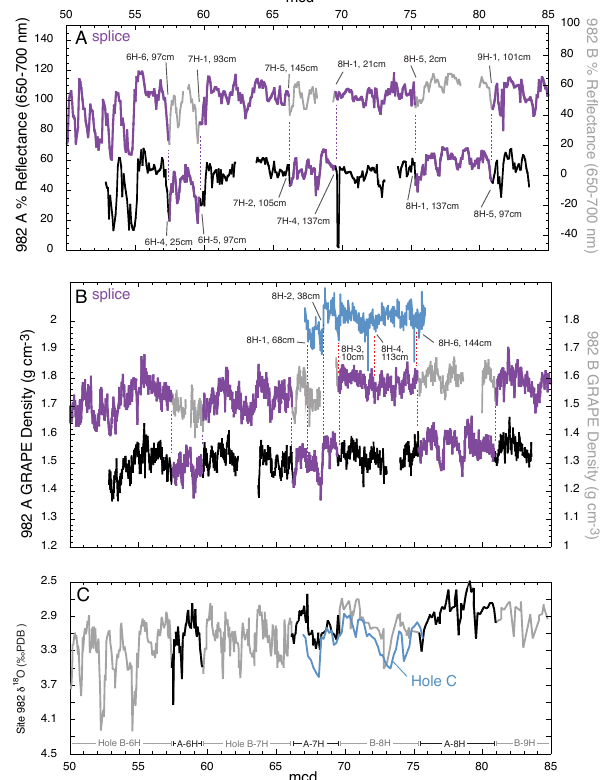
Fig. 3. Site 982 physical properties and benthic oxygen isotope data: (A) shipboard reflectance, (B) shipboard GRAPE density and (C) benthic δ 18 O data for Site 982 holes A, B and C (black, gray and blue data, respectively) and the original shipboard splice (purple data) for the interval of the Site 982 age model in question (Ship- board Scientific Party, 1996). Black labels indicate the samples at core breaks. Dashed vertical purple lines (and labels) denote tie points used to generate the shipboard splice. Dashed vertical red lines (and labels) denote tie points used to tune Hole C GRAPE data to the GRAPE data used to generate the original splice (from Hole A/B). The splice point at Hole A-8H-1, 21cm (69.55mcd), is arguably the least secure tie between holes A and B in the orig- inal splice. The Hole C GRAPE data highlight, however, that no stratigraphy is missing from the original shipboard splice due to the inclusion of the tie point at 69.55mcd. Note, no reflectance data was generated for cores 7H-9H in Hole C (Ortiz et al., 1999).